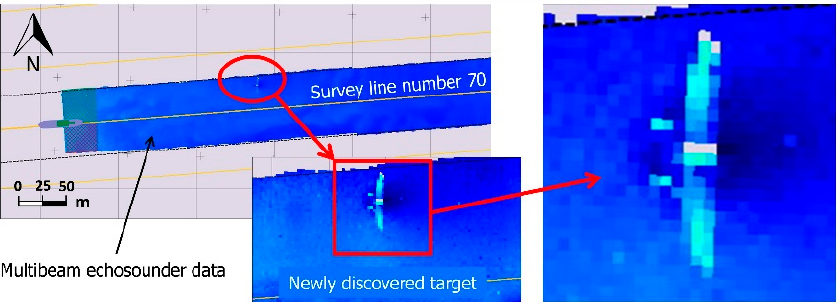
Figure 2. The moment of detecting the wreck by means of MBES on the survey line number 70.